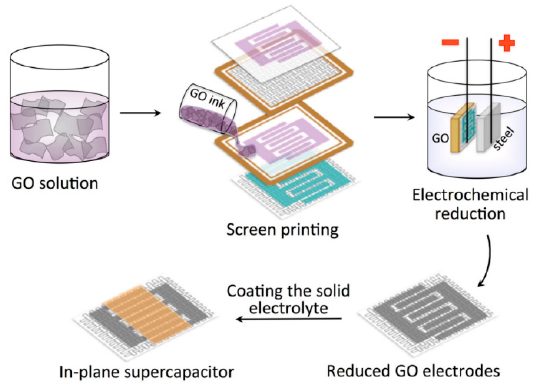
Figure 6. Screen printing of graphene oxide (GO) ink on fabrics and electrochemical reduction of graphene-based planar supercapacitors. Reproduced form [57], with permission from IOP Publishing Ltd., 2017.